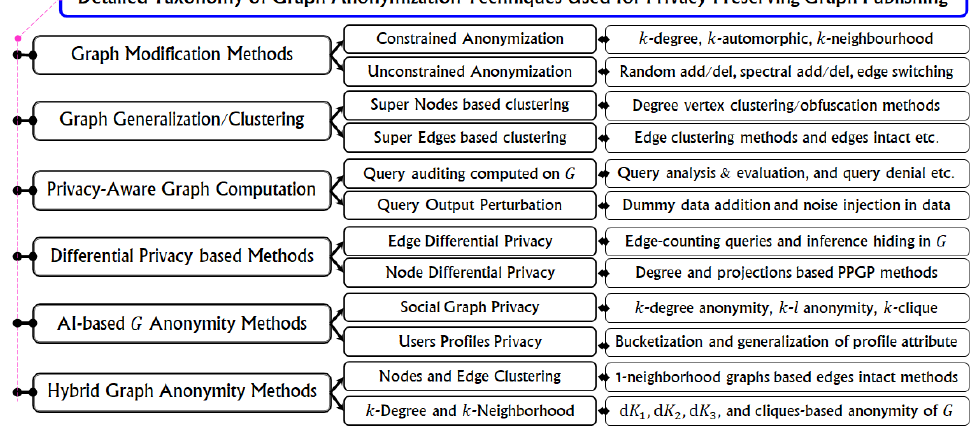
Figure 11. High-level taxonomy of the anonymization techniques applied to G for